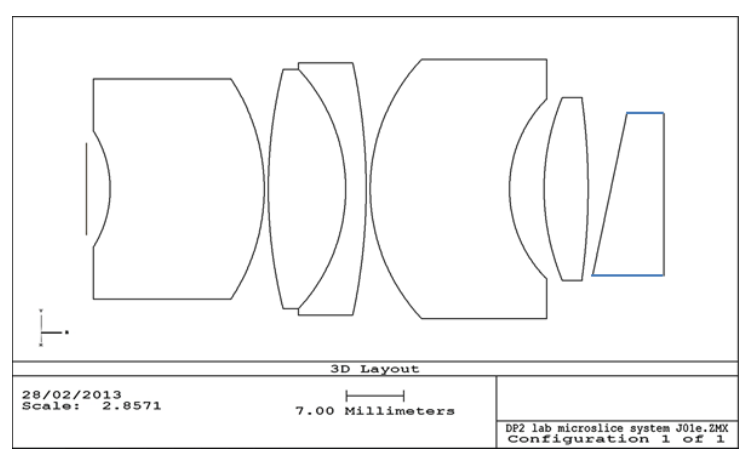
Figure 2. Layout of the